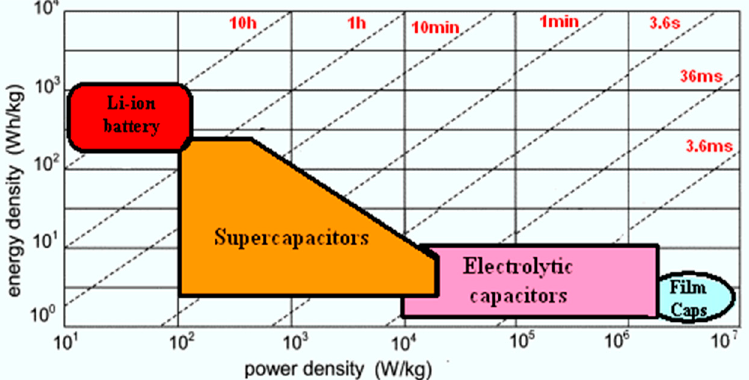
Figure 1. Ragone graph of common ESDs; the dotted lines indicate the device characteristic time (figure derived from [13]).